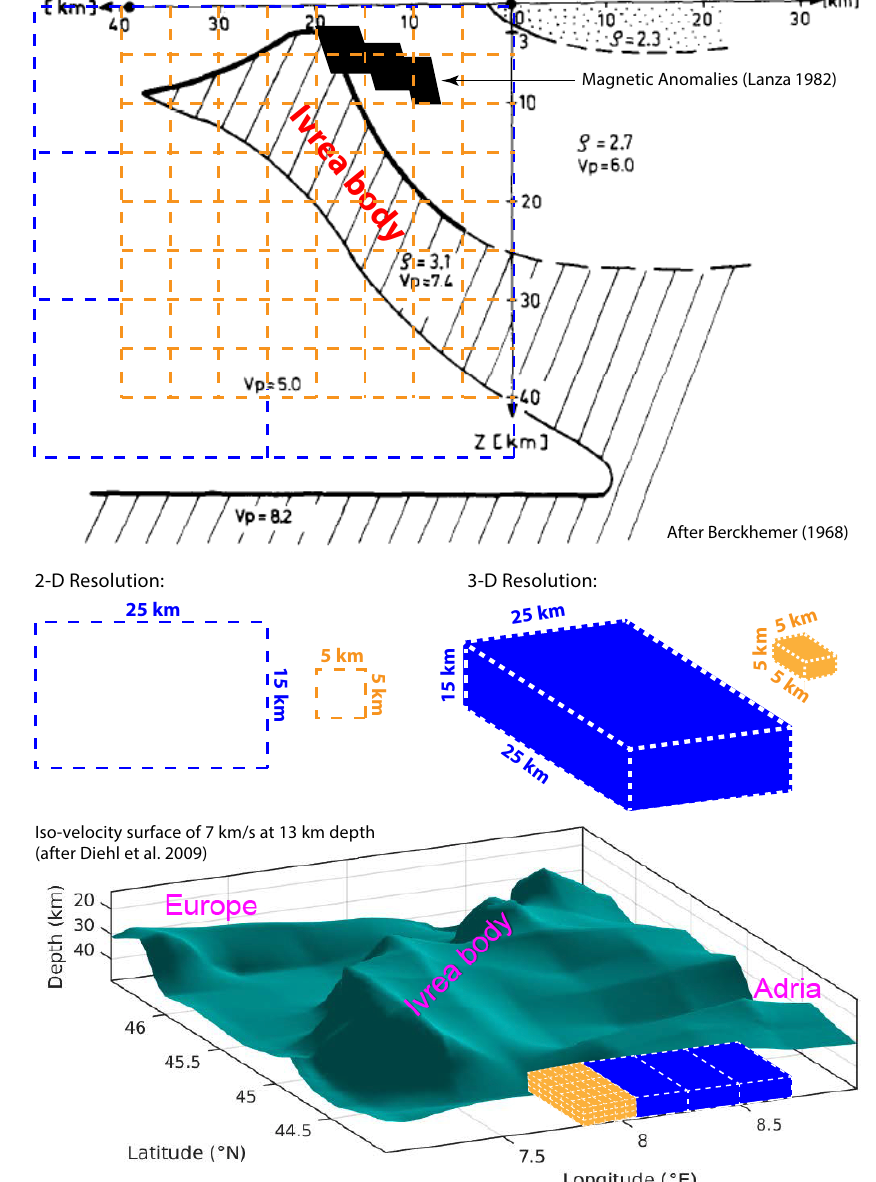
Figure 3. Cross section of the Ivrea body (“Bird’s Head model”) according to Berckhemer (1968), as determined by seismic wave velocities and gravity anomalies. Black squares are magnetically differentiated rocks with a magnetic susceptibility contrast of 5 × 10 − 1 CGS EMU (electromagnetic units in the centimetre–gram–second system) with respect to the surrounding lithologies (Lanza, 1982). Blue dashed grid indicates 2-D spatial seismic resolution achieved in the past (25km × 25km[horizontal] × 15km[vertical]; Diehl et al., 2009). Orange dashed grid indicates 2-D spatial seismic resolution (5km × 5km × 5km) to be applied in the forthcoming geophysical investigations. The higher spatial seismic resolution will allow improvements of existing 3-D geophysical models (e.g. iso-velocity surface models of Diehl et al., 2009) to image the Ivrea body at